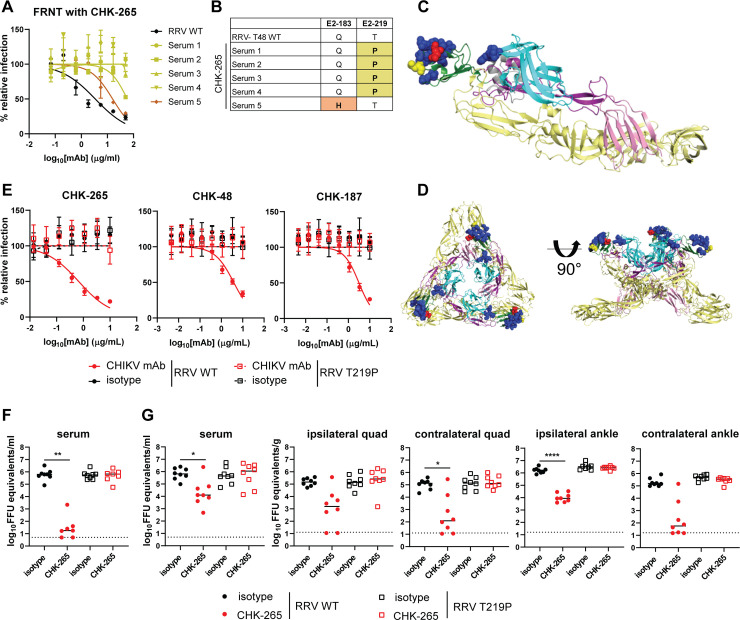
RRV escapes from neutralization by CHK-265.(A) Neutralization assay. CHK-265 was preincubated with 102 FFU of RRV derived from serum collected from CHK-265-treated mice at 3 dpi or parental RRV (RRV WT) and then added to Vero cells for 20 h. Viral foci were counted and compared to wells without mAb to determine relative infection. (B) Viral RNA was isolated from serum or from RRV WT stock and sequenced. Mutations are highlighted and indicated in bold. (C) Critical residues for CHK-265 binding determined by cryo-EM are shown as blue spheres, and identified mutations are shown as red (E2-183) or yellow (E2-219) spheres on the CHIKV p62-E1 structure using PyMOL (PDB 3N42): E1 in yellow, E3 in gray, E2-A in cyan, E2-B in dark green, E2-arch in purple, and E2-C in pink. (D) The residues highlighted in (C) modeled on the CHIKV trimeric spike using PyMOL (PBD 2XFB). (E) Neutralization assay. CHK-265, CHK-48, and CHK-187 were preincubated with 102 FFU of RRV WT or RRV E2-T219P and then added to Vero cells for 20 h. Viral foci were counted and compared to wells without mAb to determine relative infection. WNV E60 was included as an isotype control. Graphs show mean ± SD (two experiments performed in duplicate). (F-G) Four-week-old male and female WT C57BL/6 mice were treated with 100 μg of CHK-265 one day prior to inoculation with 103 FFU of RRV WT or RRV E2-T219P. Serum was collected (F) 1 or (G) 2 dpi, and (G) spleen, ipsilateral and contralateral quadriceps muscles (quad), and ipsilateral and contralateral ankles were harvested at 2 dpi. Viral titers were determined by qRT-PCR (n = 7–8 per group; two experiments). Bars indicate median values (Kruskal-Wallis with Dunn’s post-test; *P < 0.05, **P < 0.01, ****P < 0.0001).